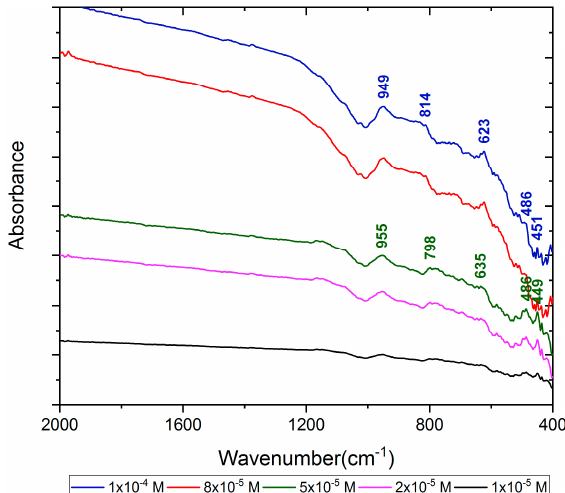
Figure 17. The DRIFT spectra of dithiophosphate adsorption on chalcopyrite with increasing collector concentration.